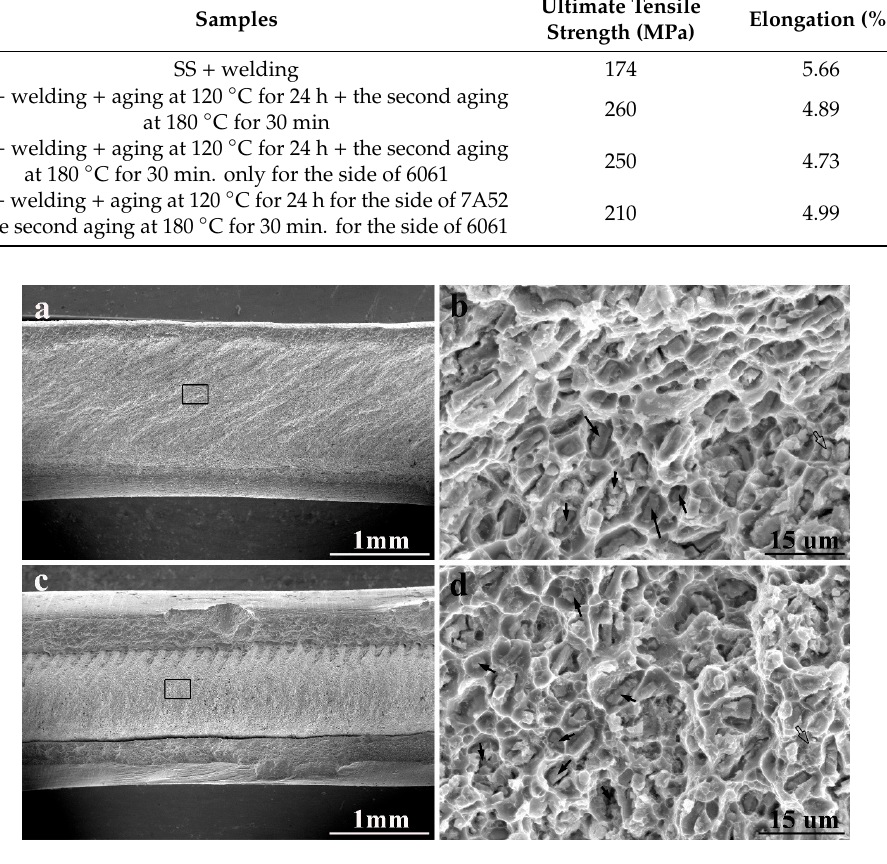
Figure 11. Fractured surface of the joint failed in the WNZ (SEM): ( a ) and ( b ) the sample of (SS + Welding); ( c ) and ( d ) the sample of (SS + welding + aging at 120 ◦ C for 24 h + the second aging at 180 ◦ C for 30 min.). ( b ) and ( d ) are the enlarged image of the boxed area in ( a ) and ( c ), respectively.